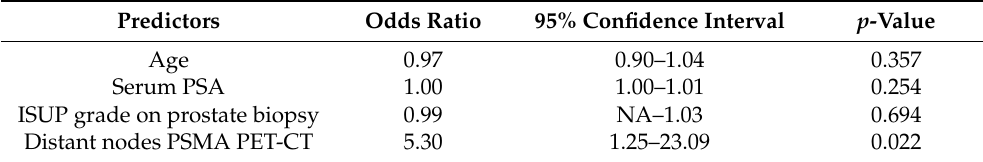
Table 6. Multivariate analysis of variables predicting treatment